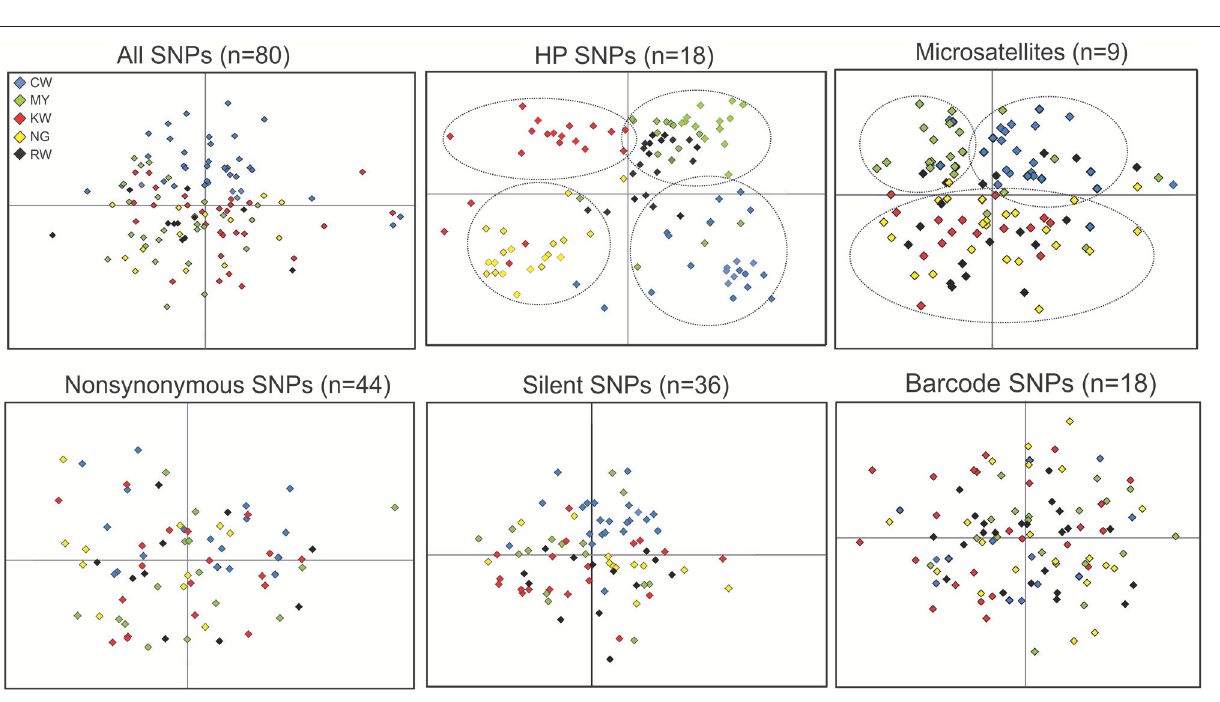
FIGURE 6 | Clustering patterns among locality samples based on the different types of SNPs and microsatellites. The first two axes that together represented over 80% of the total variation from principle component analyses are shown. The five studied sites are presented by different color (CW, blue; MY, green; KW, red; NG, yellow; RW, black). Clusters with respect to locality are indicated by dotted